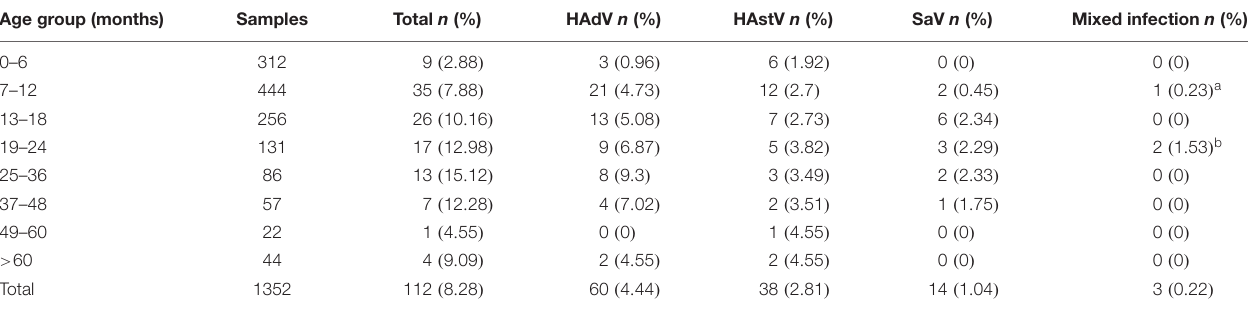
TABLE 1 | Distribution of viral pathogens in 1352 children with acute gastroenteritis different age group in Chongqing. Age group